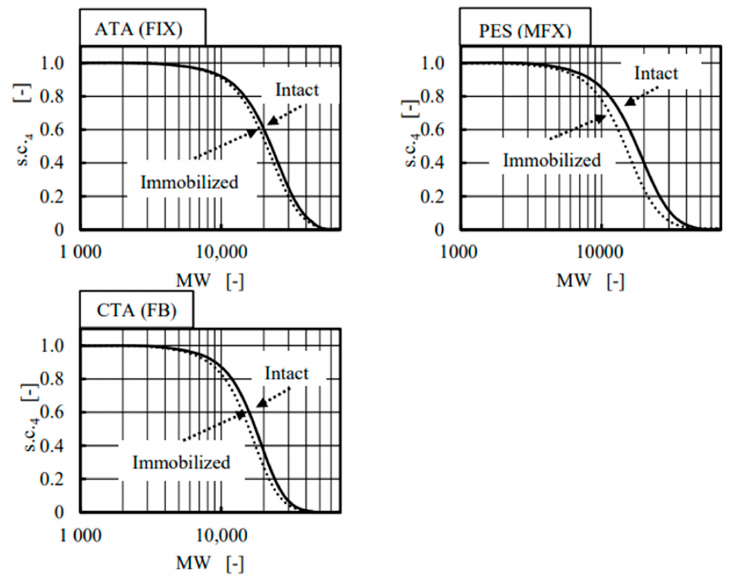
Figure 8. Comparison of cut-off curves between intact and immobilized membrae under forward (In-to-Out) filtration using dextran with wide variety of MW.